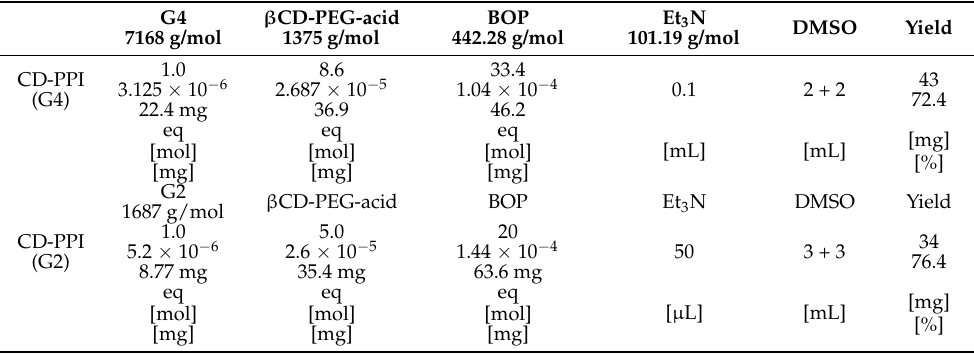
Table A1. Educts used for the synthesis of CD-PPI (G2) and CD-PPI (G4).